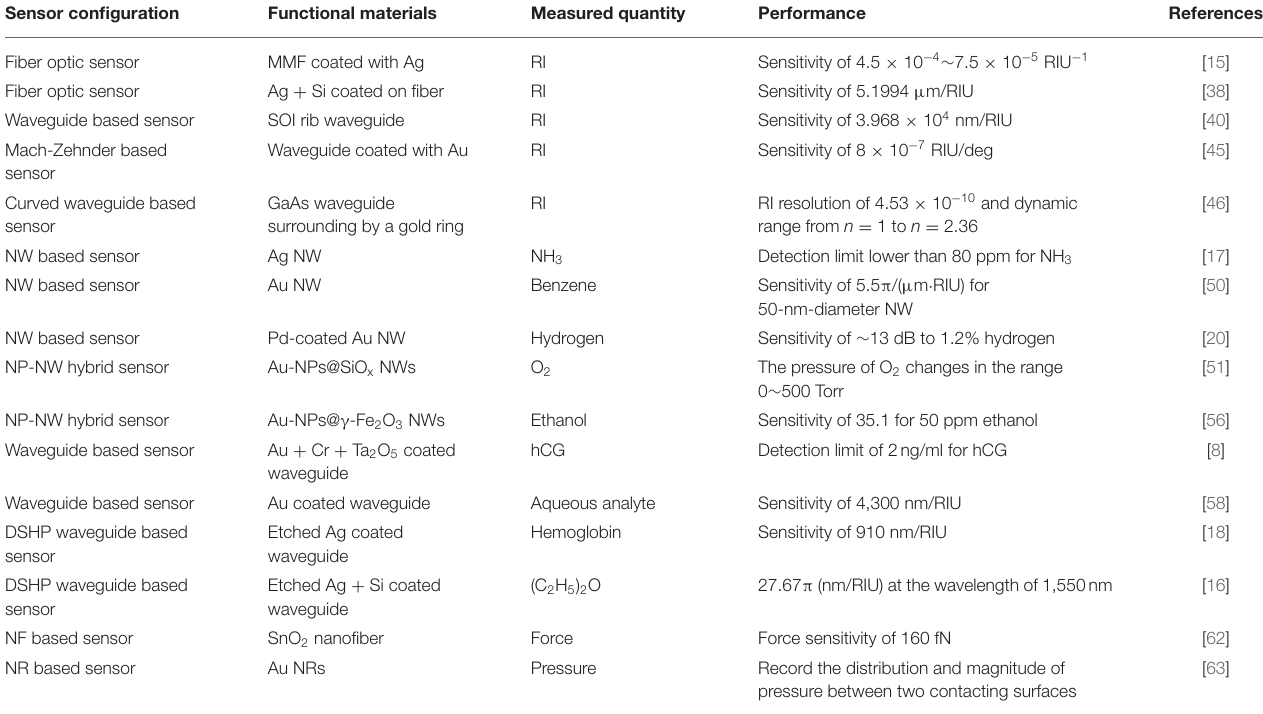
TABLE 1 | Performance of low-dimensional plasmonic